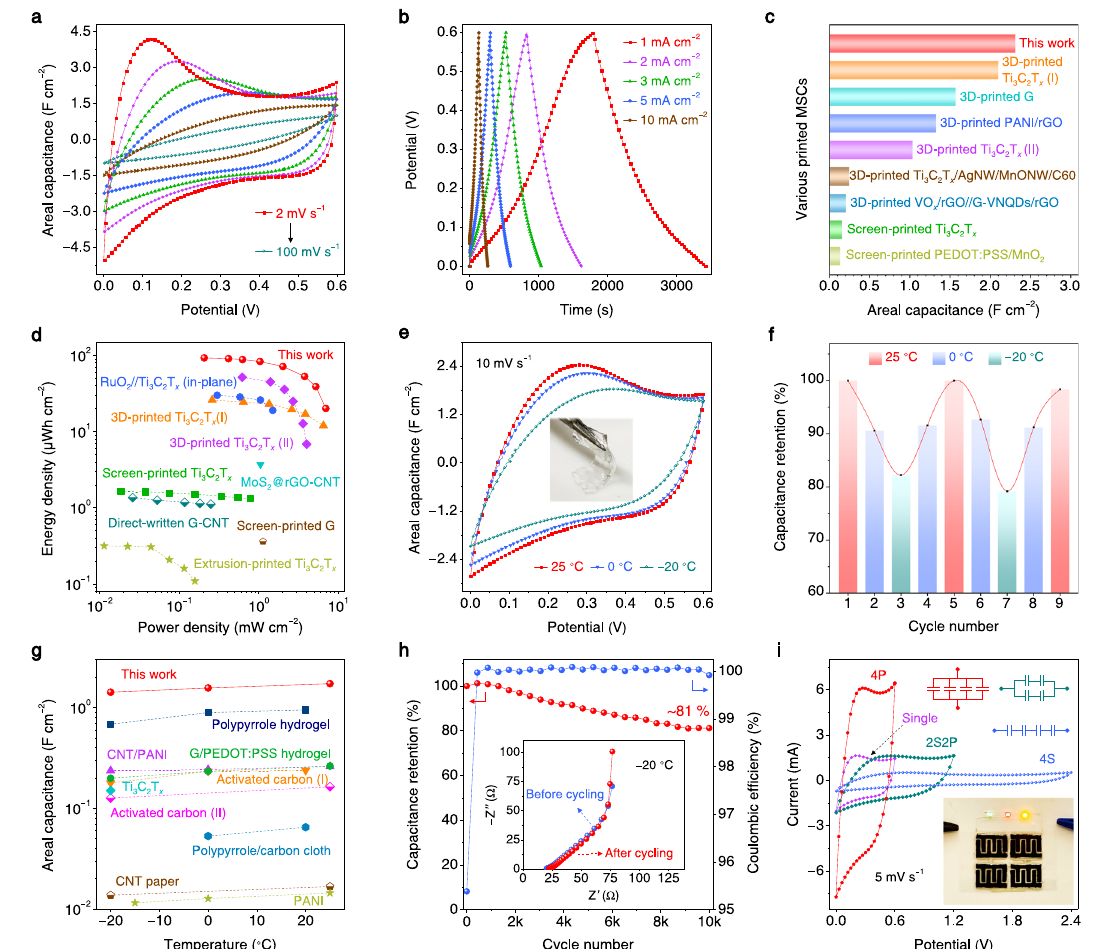
Fig. 4 | Electrochemical performance of 4D-printed Ti 3 C 2 T x hydrogel MSCs. a CVcurvesof4D-printedTi 3 C 2 T x hydrogelMSCatscanratesof2,5,10,20,50,and 100mV s − 1 . b GCD curves of 4D-printed Ti 3 C 2 T x hydrogel MSC at current densities of 1, 2, 3, 5, and 10mAcm − 2 . c Comparison of areal capacitance of 4D-printed Ti 3 C 2 T x hydrogel MSC with other printed MSCs. d Ragone plots of 4D-printed Ti 3 C 2 T x hydrogel MSC and other high-performance MSCs. e CV curves of 4D- printed Ti 3 C 2 T x hydrogel MSC at a scan rate of 10mVs − 1 at 25°C, 0, and − 20°C. Inset is the PVA-EG-H 2 SO 4 gel electrolyte at − 20°C, showing great transparency and fl exibility. f Capacitanceretentionof4D-printed Ti 3 C 2 T x hydrogelMSCduring